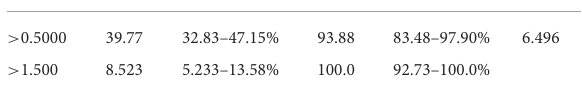
TABLE 3 ROC curve table comparing the percentage of nerves with at least one altered 1 TpT ( > 2.5 mm 2 - focality) between healthy individuals and patients with